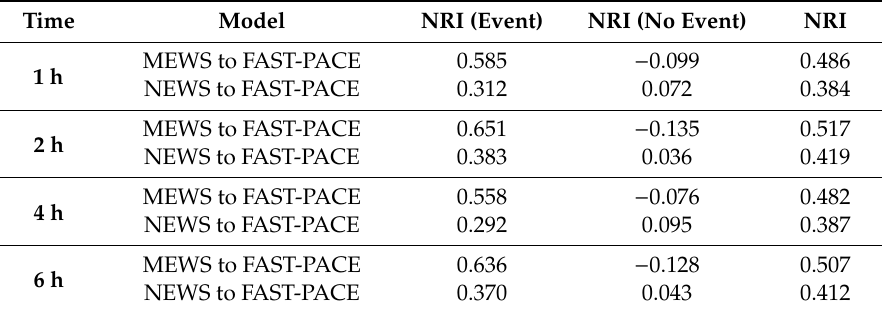
Table 7. NRI in predicting cardiac arrest.